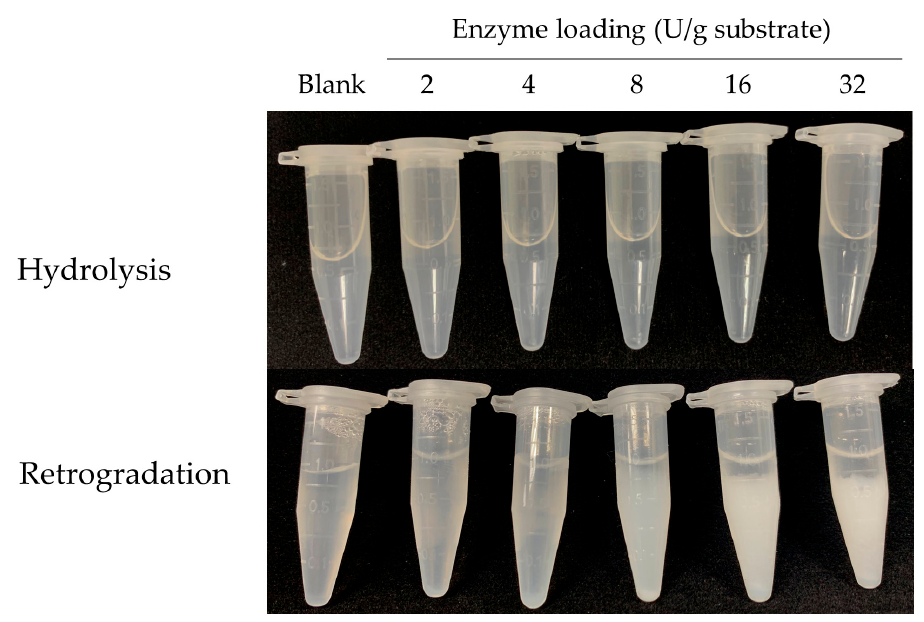
Figure 6 Figure 6. Resistant starch production via HL12Pul, the effect of varying enzyme dosage for resistant starch produced from cassava paste was evaluated. The varying HL12Pul loading contained 2, 4, 8, 16, and 32 U/g